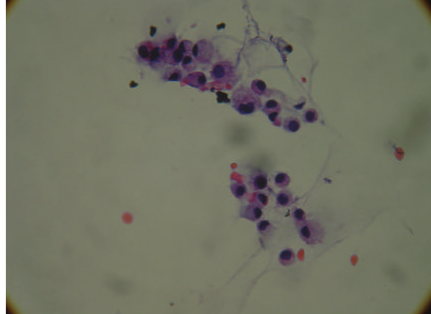
Figure 2: High power view of adenocarcinoma cells in cerebral spinal fluid.